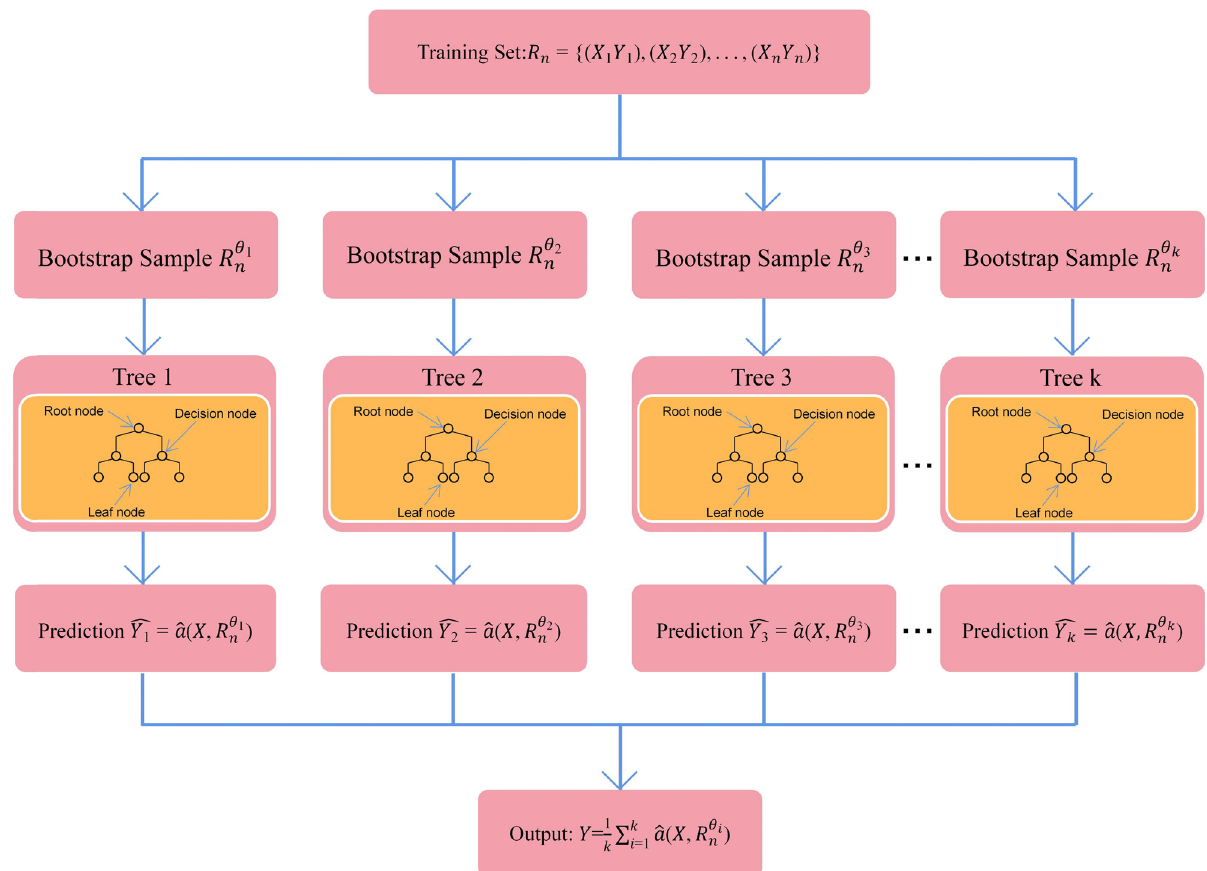
Figure 7: Construction of an RF